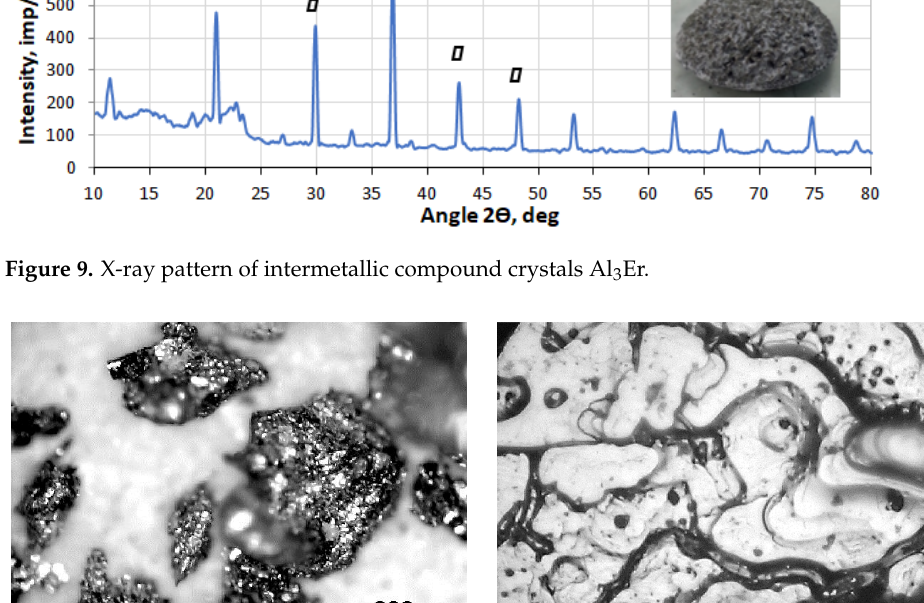
Figure 10. Microimages of intermetallide crystals Al 3 Er. After their separation into a separate phase, their thermodynamic properties were determined. The DSC heating curve of the intermetallic compound is shown in Figure 11. The temperature of 645.75 °C corresponds to the isothermal line of the eutectic reac- tion L → (Al) + (Al 3 Er), and the temperature of 989.84 °C corresponds to the peretectic transformation Al 3 Er = Al 2 Er + Al. At a temperature of 1123 °C, an endothermic effect corresponding to the liquidus point was registered.